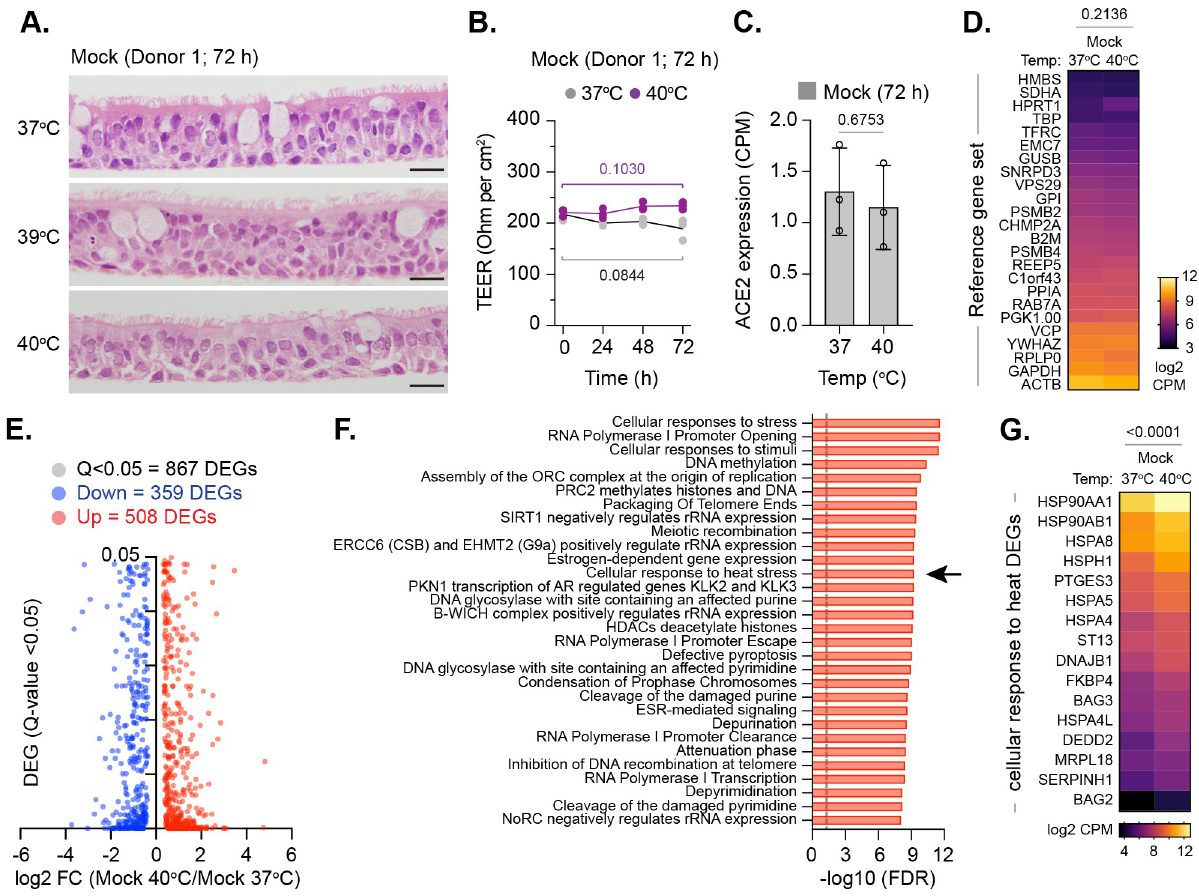
Fig 2. Respiratory airway cultures induce a heat stress response upon incubation at elevated temperature. Ciliated respiratory cultures differentiated from HBEp cells isolated from 3 independent donors (donor 1, male Caucasian aged 63 years; donor 2, Hispanic male aged 62 years; donor 3, Caucasian female aged 16 years; all nonsmokers) were incubated at 37, 39, or 40˚C for 72 h prior to fixation or RNA extraction and RNA-Seq. (A) Representative H&E stained tissue sections (donor 1) at 72 h. Scale bars = 20 μ m. (B) TEER (Ohm per cm 2 ) measurements of respiratory epithelia integrity (donor 1) at 37 or 40˚C. N = 3 tissues per condition; lines, mean; all data points shown; p -values shown, unpaired two-tailed t test. (C) ACE2 expression levels (CPM) in respiratory cultures incubated at 37 or 40˚C; means and SD shown; p -value shown, unpaired two-tailed t test. (D) Expression values (log2 CPM) of a reference gene set (24 genes; [34–36])in respiratory cultures incubated at 37 or 40˚C; p -value shown, paired two- tailed t test. (E) Scatter plots showing high confidence (Q < 0.05) DEG transcripts identified between respiratory cultures incubated at 37 or 40˚C; up- regulated DEGs, red circles; down-regulated DEGs, blue circles. (F) Reactome pathway analysis of mapped up-regulated DEGs. Top 30 pathways (FDR < 0.05; plotted as − log10 FDR) shown. Dotted line, threshold of significance ( − log10 FDR of 0.05). (G) Expression values (log2 CPM) of DEGs associated with cellular response to heat stress pathway (R-HSA-3371556; arrow in F); p -value shown, paired two-tailed t test. (C to H) RNA-Seq data derived from RNA isolated from 3 donors (donors 1 to 3) per sample condition derived from 3 independent experiments per donor. Raw values presented in S1 and S9 Data. ACE2, angiotensin-converting enzyme 2; CPM, counts per million; DEG, differentially expressed gene; FDR, false discovery rate; HBEp, human bronchiolar epithelial; H&E, hematoxylin and eosin; TEER, transepithelial electrical